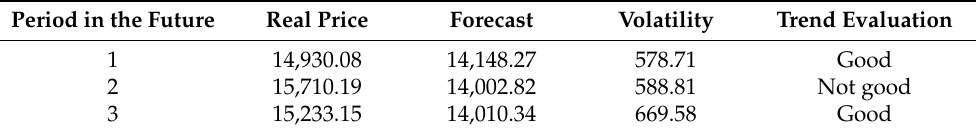
Table 13. Forecasts of the all-terms group of the Shenzhen Index.